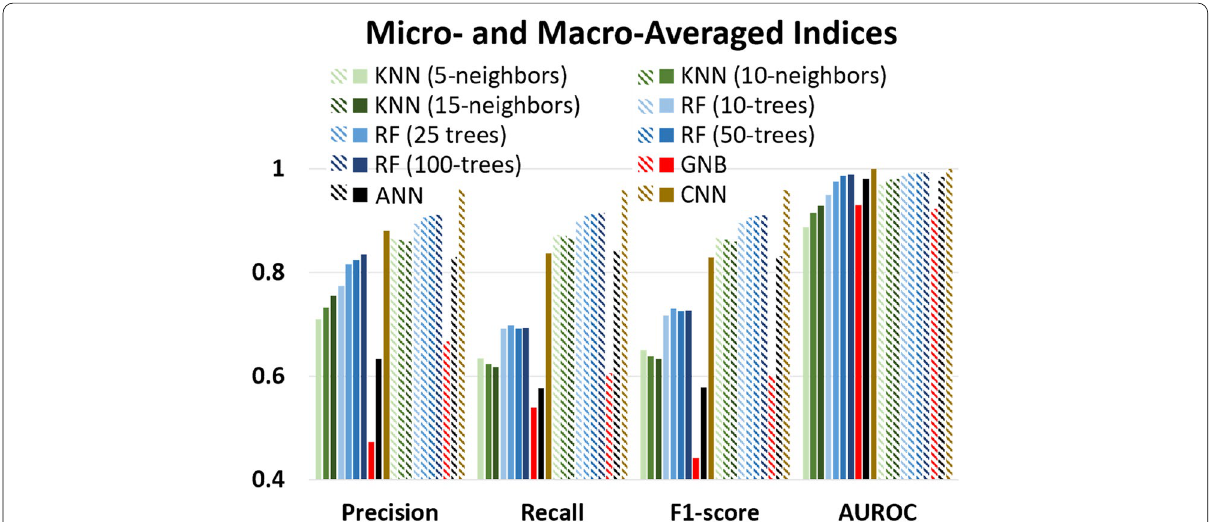
Fig. 5 The evaluation indices (macro‑ and micro‑average of precision, recall, F1‑score, and AUROC) for different machine learning classifiers. Solid (stripe) shading indicates the macro‑(micro‑) averaged indices